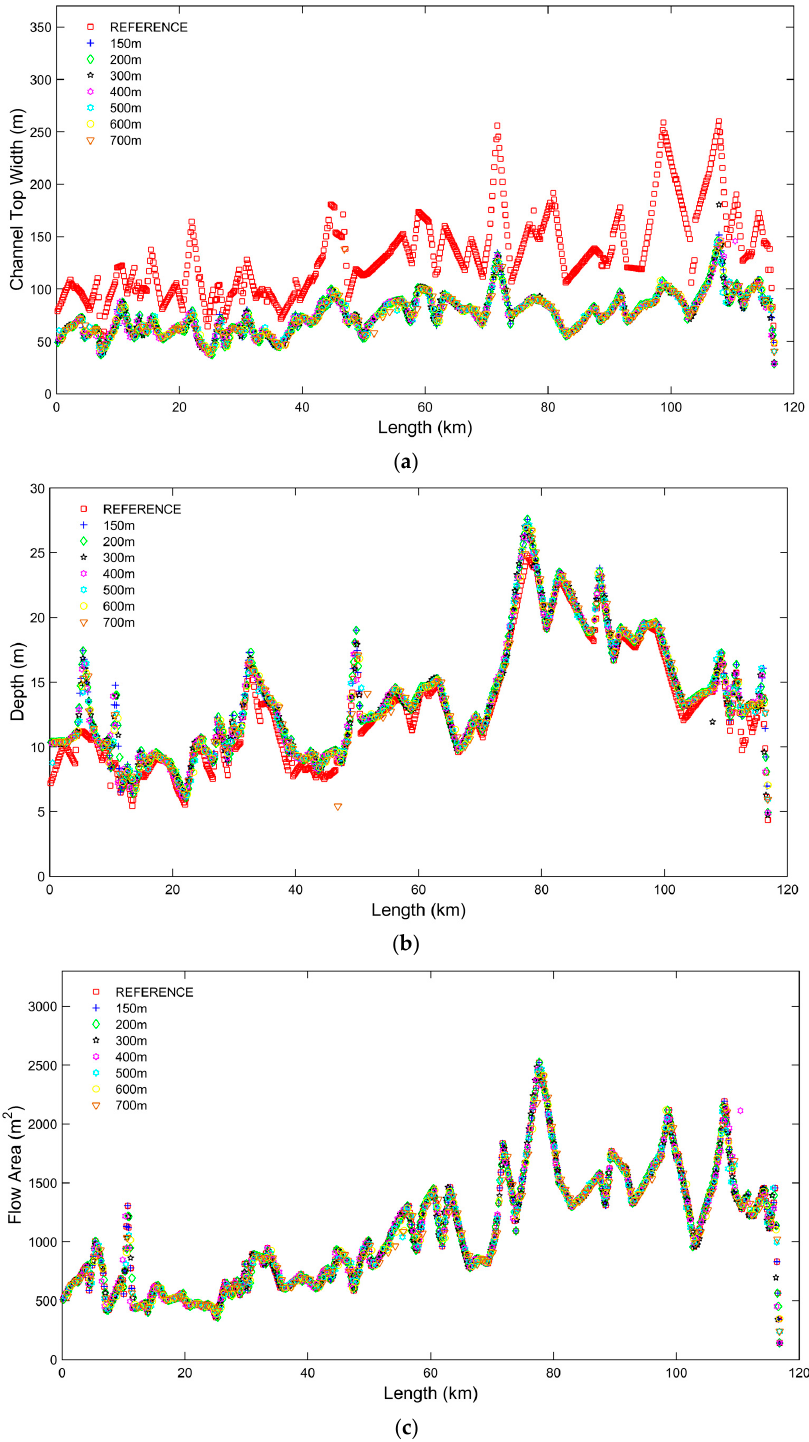
Figure 4. Plots of channel top width ( a ), depth ( b ) and flow area ( c ) using the different model set ups: from the 150 m reference model using the naturally surveyed cross sections to the seven realizations of the synthetic rectangular channel flood model for 150 m, 200, 300 m, 400 m, 500, 600 m and 700 m